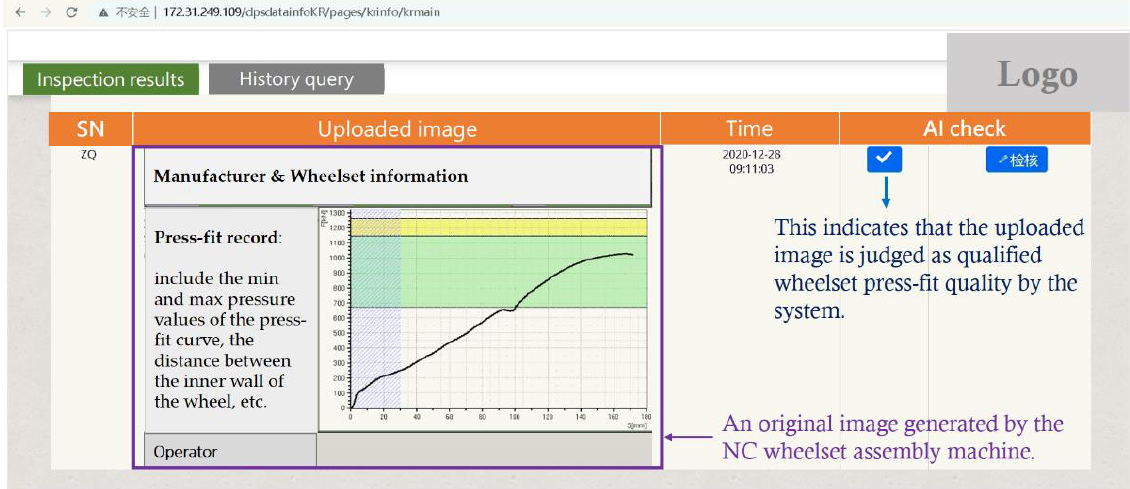
Figure 5. The query page of inspection results for the proposed system.